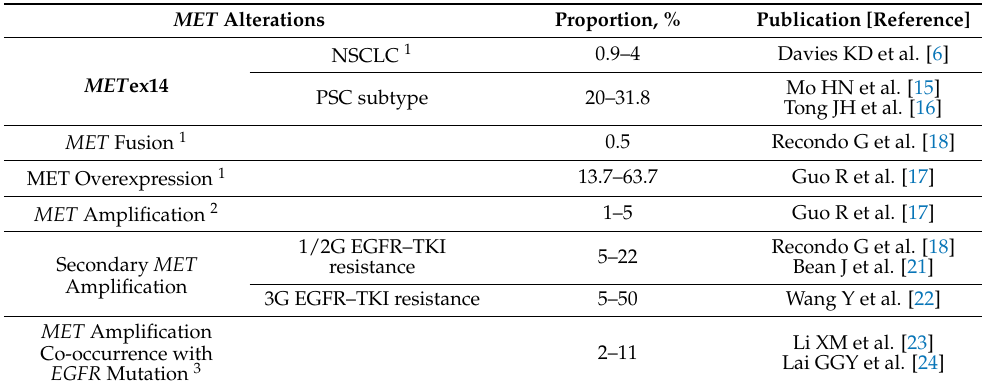
Figure 1. Exploration of MET as oncogene and the journey leading to the development of MET – TKI. 1 Based on overall NSCLC population. 2 Based on treatment-naïve NSCLC population. 3 Based on EGFR -positive treatment-naïve NSCLC population. Table 1. Proportion of different MET alterations in NSCLC patients.